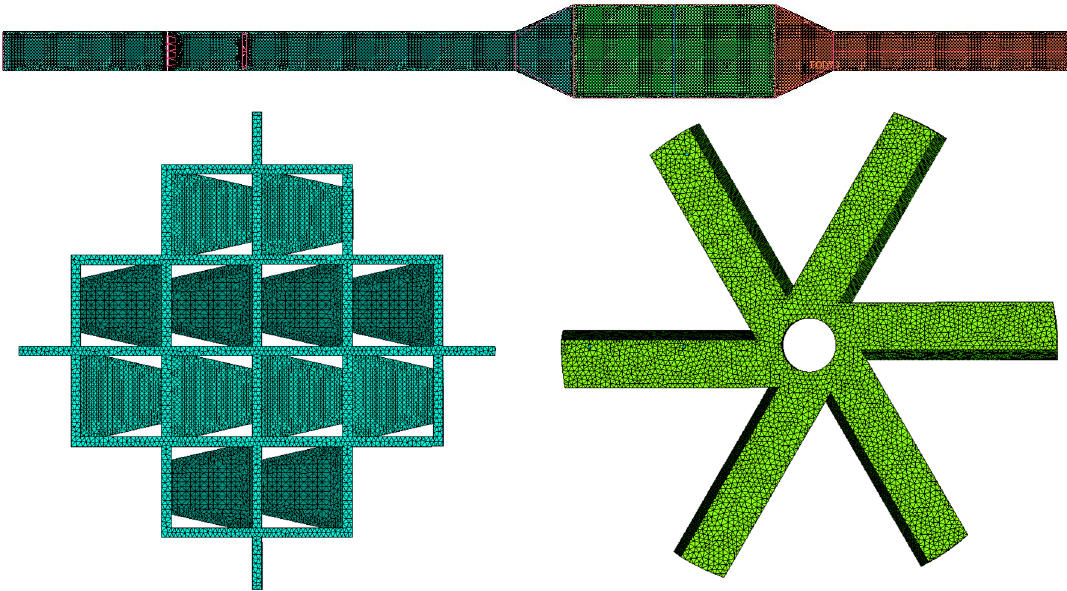
Figure 2. Mesh grids of computational domain.